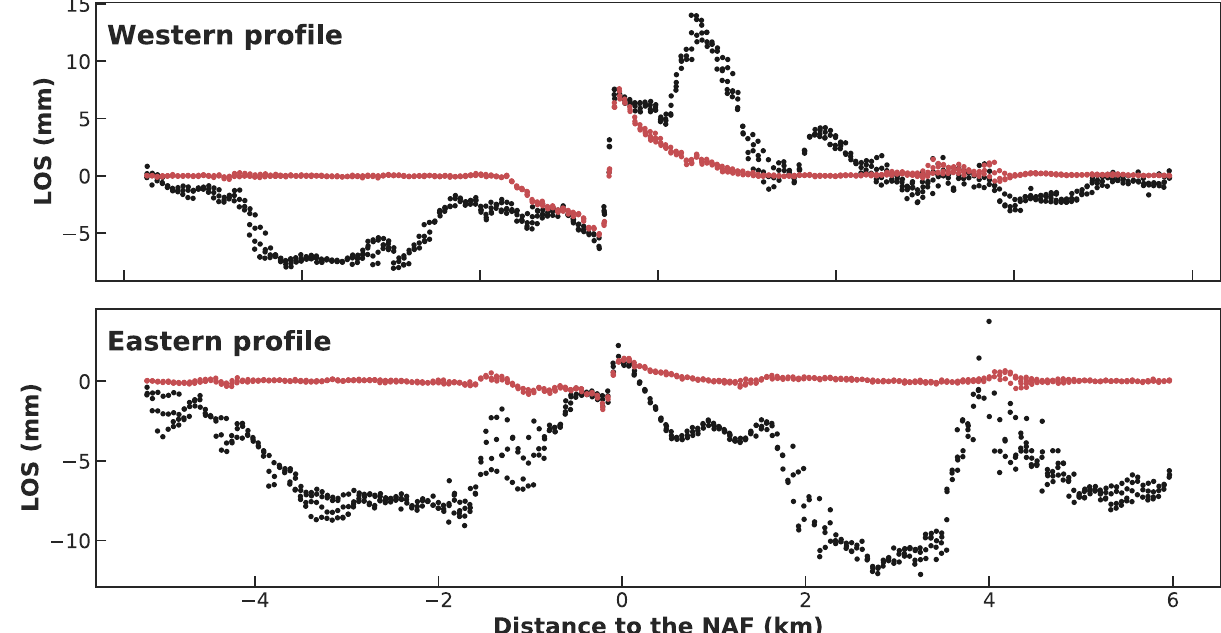
Fig. 4 Application to real data: the North Anatolian Fault 2013 slow earthquake. LOS deformation along fault-perpendicular cross-sections. Locations of the cross-sections are shown in Fig. 3. Blacks dots are the difference between the range change averaged between frames of the time series from 5th to 21st September 2013 (the last four frames) and the range change averaged between frames of the time series from 4th to 28th August 2013 (the fi rst fi ve frames), taken along a fault-perpendicular line. The main slow-slip event detected by Rousset et al. occurred during this period. Red dots are the output of the deep autoencoder highlighting the cleaned deformation pattern. The sharp offset in the input InSAR data observed exactly on the fault was interpreted as a slow-slip event by Rousset et al., in spite of the very high noise level presumably caused by atmospheric delays. Such interpretation was only made possible owing to the knowledge of the location of the fault and knowledge that this segment of the North Anatolian Fault slips aseismically. Our model knows neither and automatically extracts actual ground